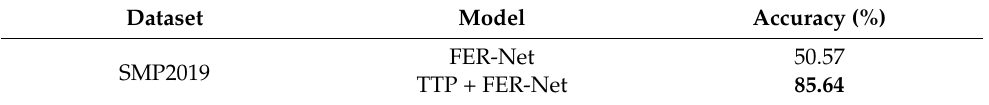
Table 5. Results of ablation experiments on SMP2019 dataset. (Two classifications: positive, negative).